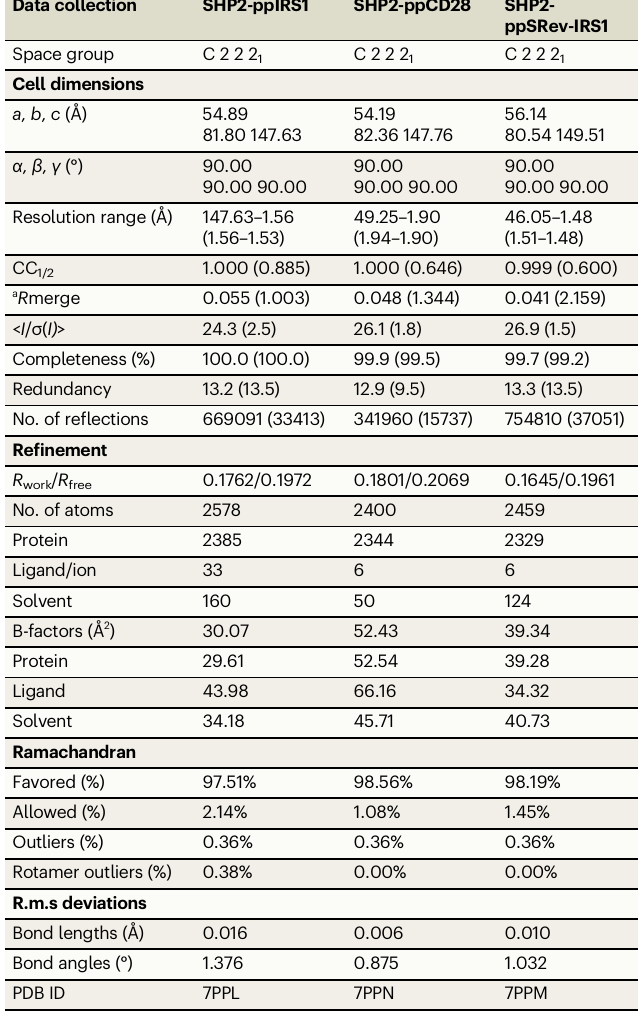
Table 1 | Details of crystal structure solution and re fi